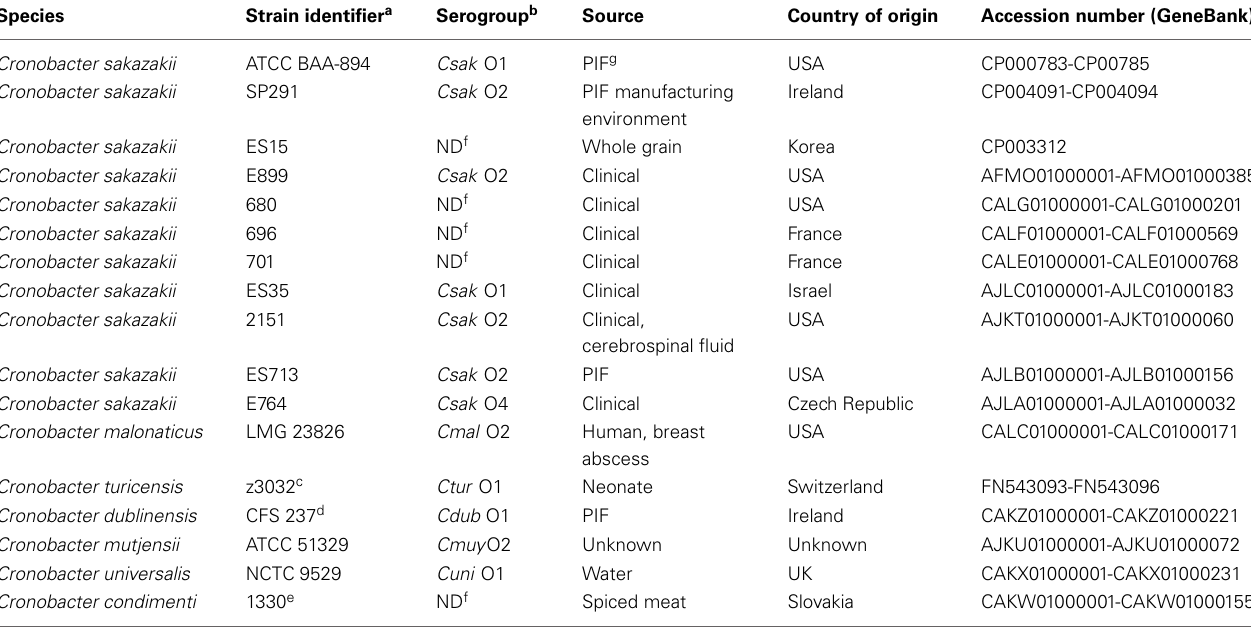
Table 1 | Cronobacter species, the strain identifier, source, country of origin, and accession numbers. Species Strain identifier a Serogroup